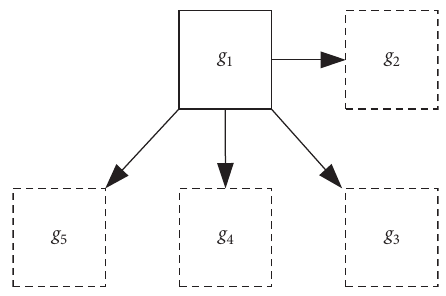
Figure 9: Gray-Level Cooccurrence Matrix generation